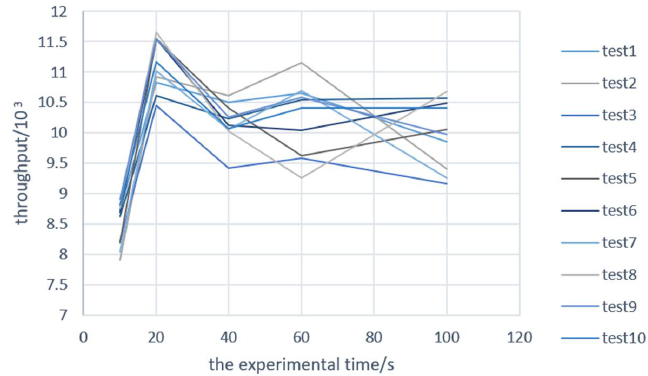
Figure 6. Transaction throughput of different blocks.